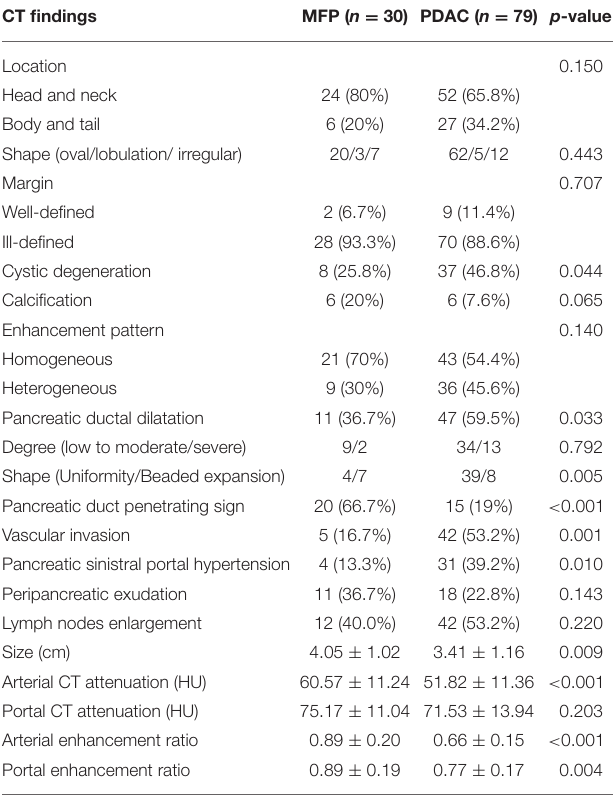
TABLE 2 | CT imaging features of patients with MFP and